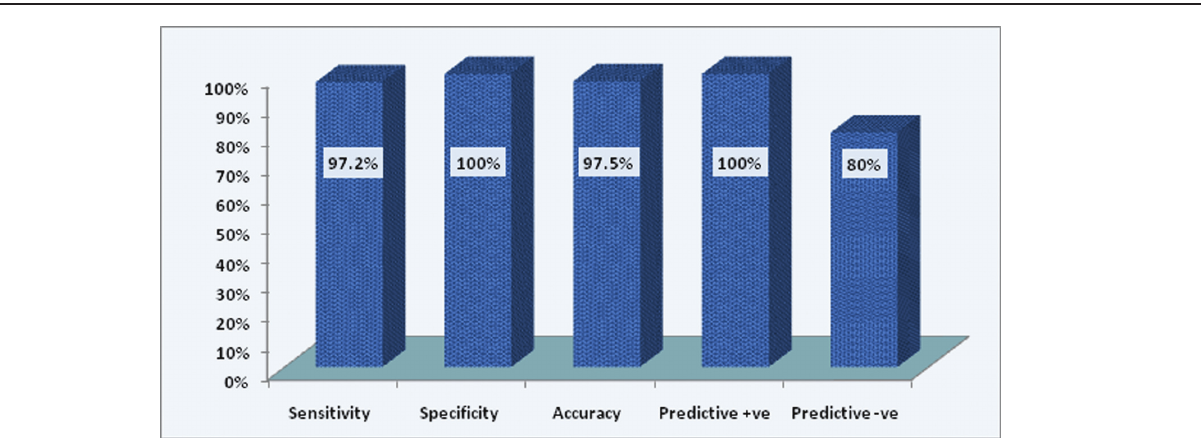
Characteristics of the tracheal ultrasonography for tracheal intubation